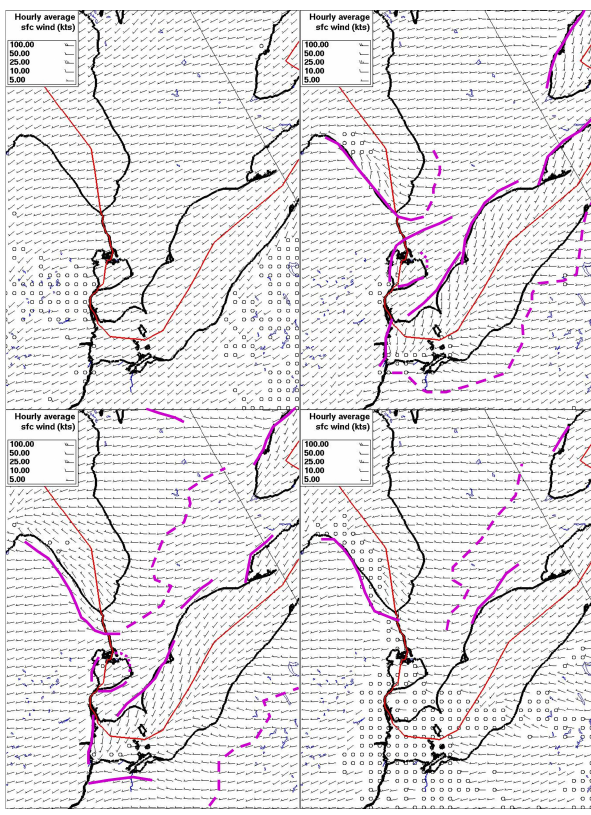
Fig. 17. 23-day average wind fields at (a) 12:00UT, (b) 16:00 UT, (c) 20:00 UT, and (d) 00:00 UT; 08:00 a.m., 12:00 p.m., 04:00 p.m., and 08:00 p.m. local time, respectively. Convergence regions marked as solid mauve lines, boundary of divergence outflow re- gions marked with dashed mauve lines.